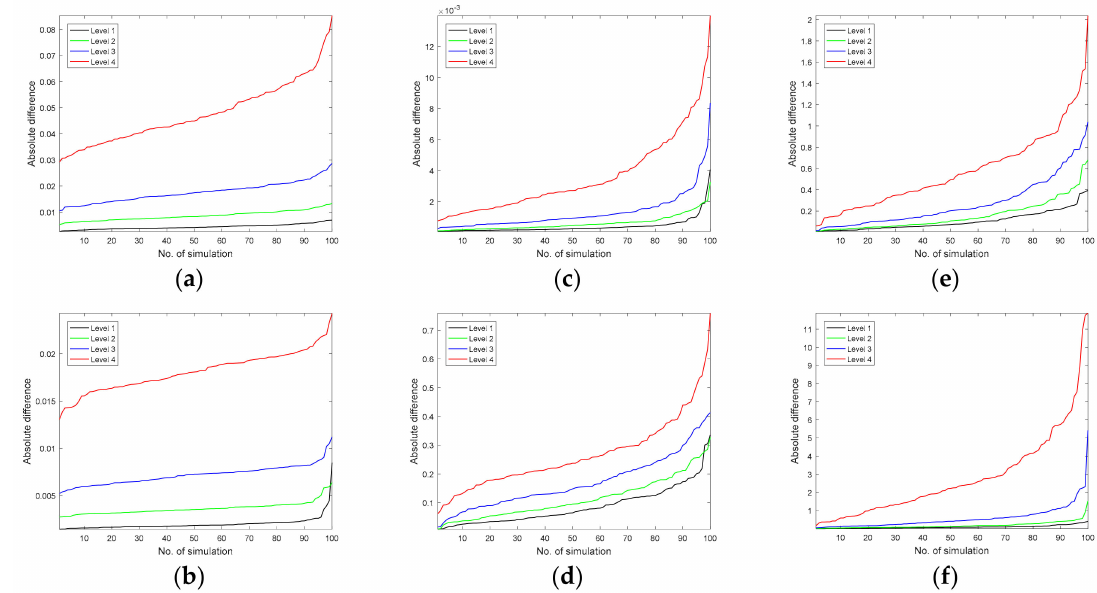
Figure 9. Sorted absolute average differences, obtained for 100 different simulations, calculated between the corresponding samples in the space of principal components constructed using the Gram PCA approach for original second-order chromatographic signals and data with peak shifts and: ( a ) four levels of Gaussian noise concerning the largest observed peak (level 1: 2.27%, level 2: 4.54%, level 3: 9.08%, and level 4: 22.7%), ( b ) four levels of heteroscedastic noise concerning the largest observed peak (level 1: 1.68%, level 2: 3.36%, level 3: 6.72%, and level 4: 18.8%), ( c ) four levels of baseline concerning the largest observed peak (level 1: 0.54%, level 2: 1.07%, level 3: 2.14%, and level 4: 5.35%). Subplots ( d , e ), and ( f ) present sorted average differences in explained data variance by the corresponding principal components constructed using the Gram PCA approach for original chromatographic signals and signals with peak shifts and obtained for the same situations and levels as in subplots ( a – c